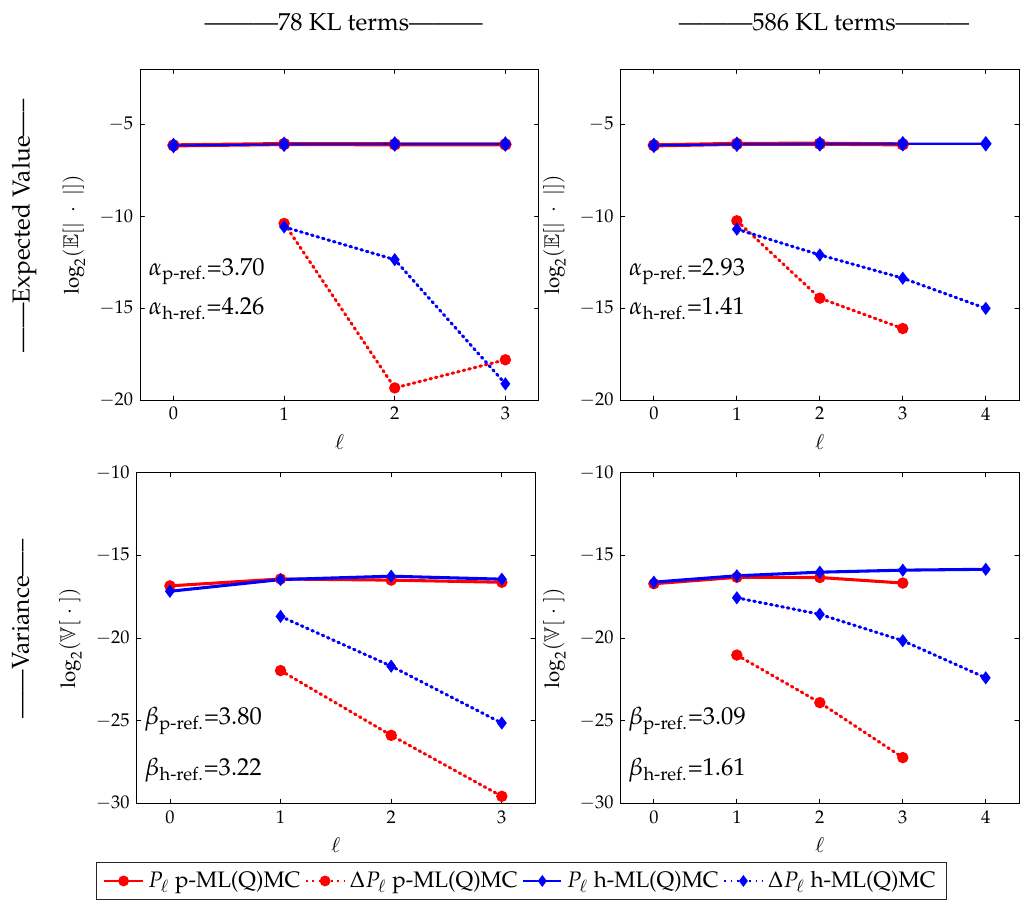
Figure 15. Variances and expected values for model problem 1.